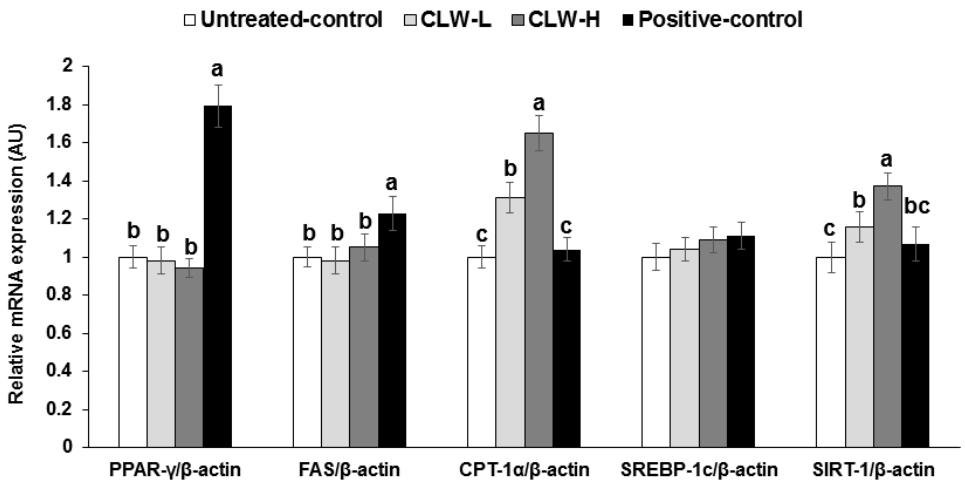
Figure 1. mRNA expression of genes related to fat metabolism in the adipose tissues. Px rats fed a high-fat diet supplemented with 0.3% lyophilized water extract of C. lanceolata + 0.7% cellulose (CLW-L), 1% lyophilized water extract of C. lanceolata (CLW-H), 1% cellulose (untreated control), or rosiglitazone (20 mg/kg body weight/day; positive control) + 1% cellulose. After 8-week treatment, adipose tissues were collected and cDNA was made from adipose tissues. The mRNA expression of PPAR- γ , CPT-1, SREBP-1c, FAS, and SIRT-1 was measured in the adipose tissues by real-time PCR. Bars and error bars represent means±standard deviation ( n = 8). a,b,c Different superscripts on the bars of each variable indicate significant differences in each variable by Tukey test.